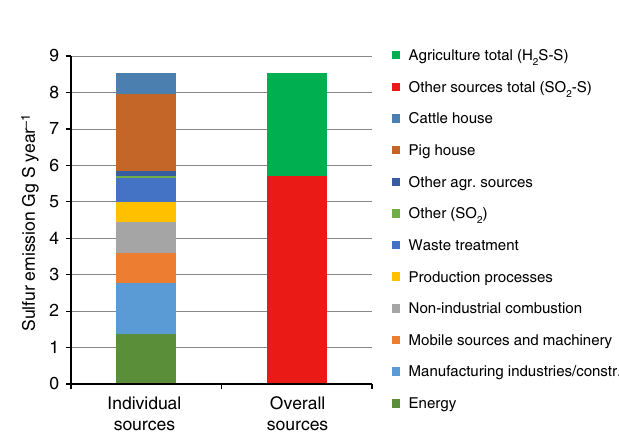
Fig. 2 Estimated sulfur emissions for agricultural and non-agricultural sources. Sulfur is emitted as H 2 S and SO 2 from agricultural and non-agricultural sources, respectively, and is reported in gigagrams sulfur per year. Data for non-agricultural sources (SO 2 -S) is extracted from CEIP 13 . Other (SO 2 ) includes road transport, solvent use, and agricultural SO 2. Other Agricultural Sources include slurry application (all categories) as well as fur (mink), poultry, sheep, and horses. Sulfur emissions from agricultural sources (H 2 S-S) are estimated based on values of R S/N measured as a part of this study or estimated based on available